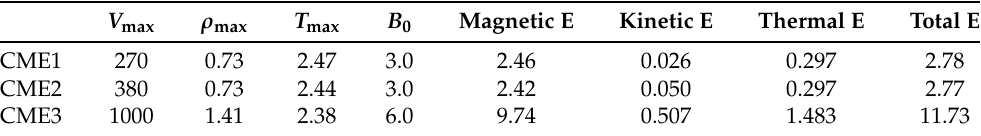
Table 1. Perturbation parameters (velocity unit: km s − 1 , density unit: 10 7 cm − 3 , temperature unit: 10 6 K) used in simulating the three successive CMEs and their corresponding energies (E represents energy with unit: 10 31